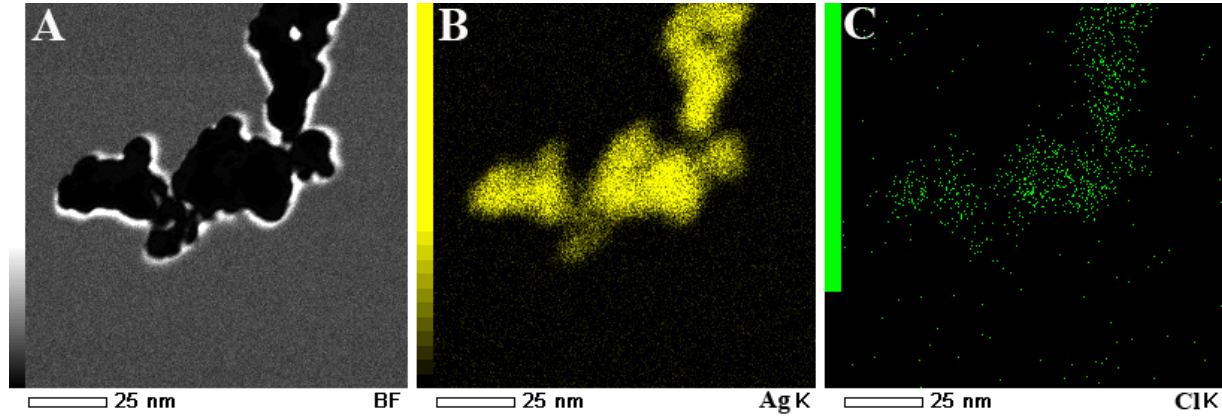
Figure 3. ( A ) Transmission electron microscopy (TEM) and ( B ) high-resolution transmission electron microscopy (HRTEM) images of Ag/AgCl nanoparticles.